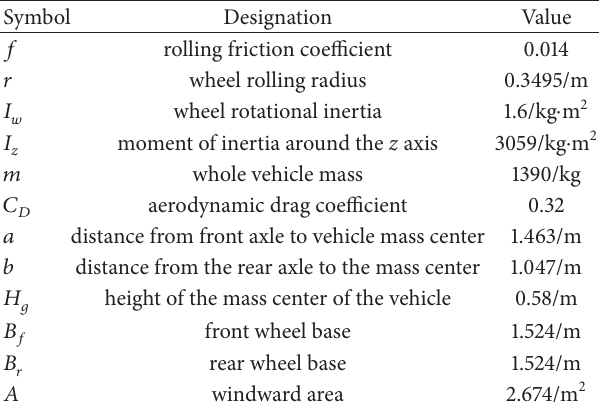
Table 1: DUTIV intelligent vehicle parameters.